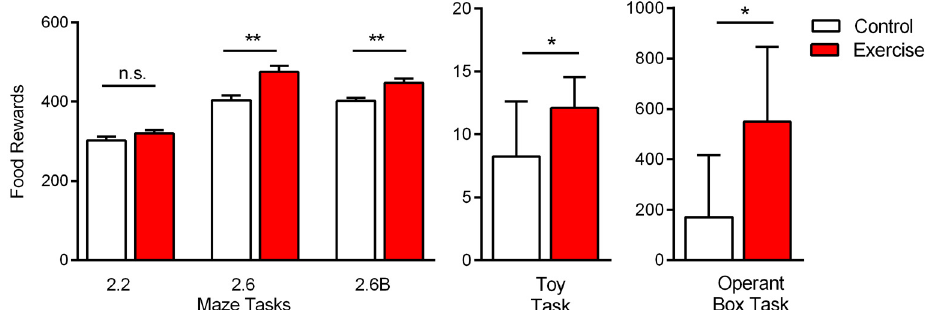
Fig 6. Cumulative Reward Gain. When each group member ’ s overall reward gain was pooled into a measure of cumulative reward gain for the group, the Exercise group obtained more reward at the end of the study as compared to Control. Significant pairwise differences (t-test, p < 0.05) were observed in all tasks except the 2:2 maze task. Data are shown as mean ± SEM; for each group n = 8.